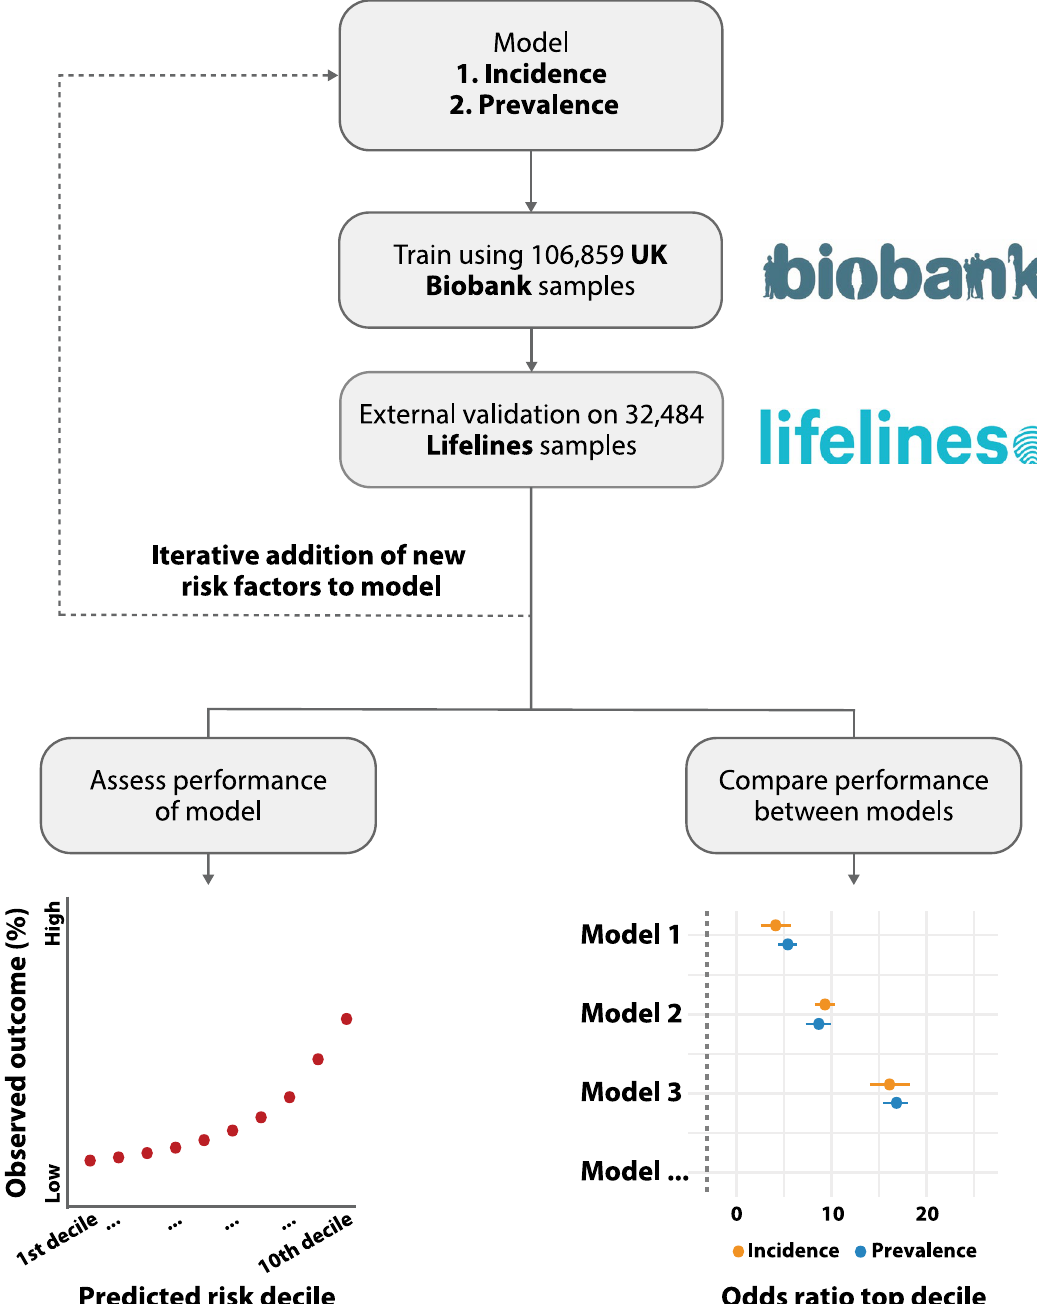
Figure 1. Training and validation setup study (concept). Models were trained based on a subset of UK Biobank individuals and validated in both the remainder of the UK Biobank individuals and the Lifelines